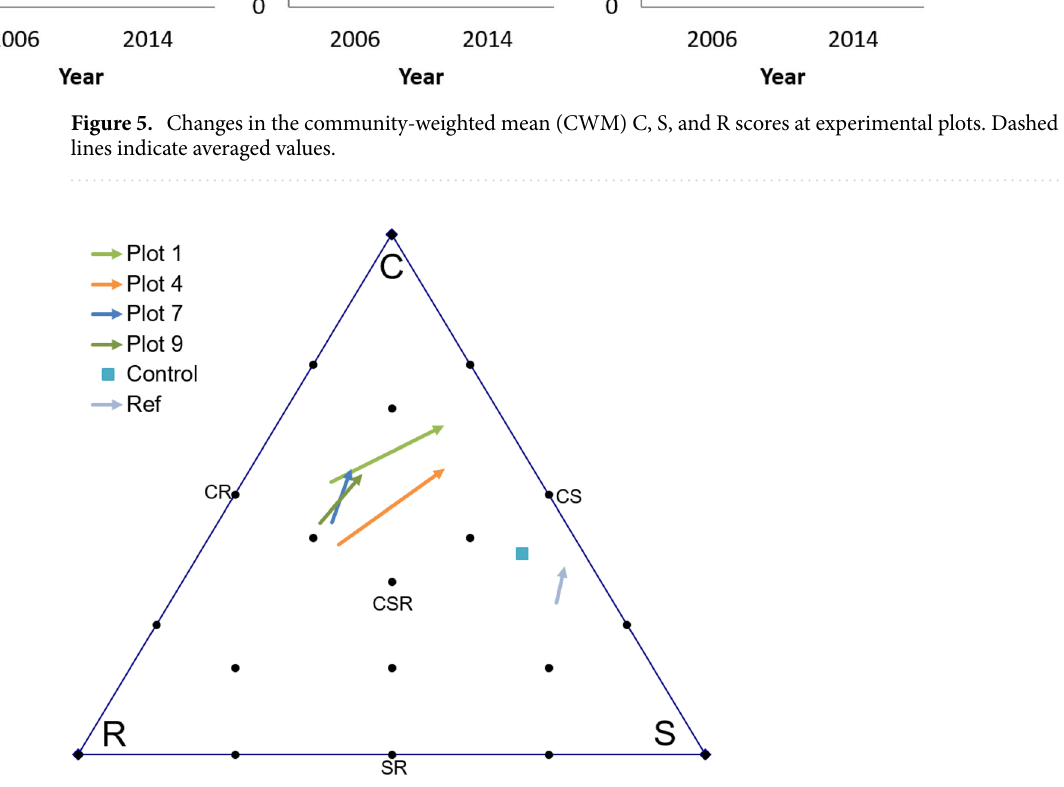
Figure 6. Trajectories of changes in competition–stress–ruderality (CSR) positions for experimental and reference plots. Only the plots with the two lowest and the two highest Euclidian distance (Table 3) are shown. Arrow: rear end corresponds to 2006 and tip to 2014. Blue square represents control plot in 2014. Ref represents reference